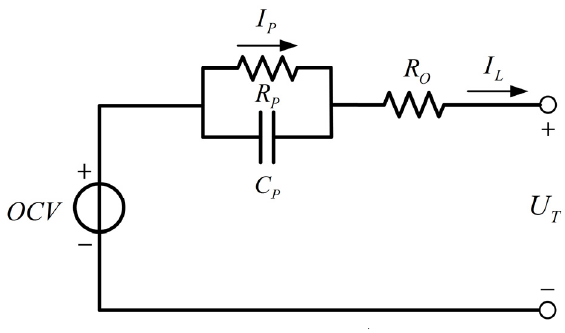
Figure 1. First-order resistance–capacitance (RC) circuit